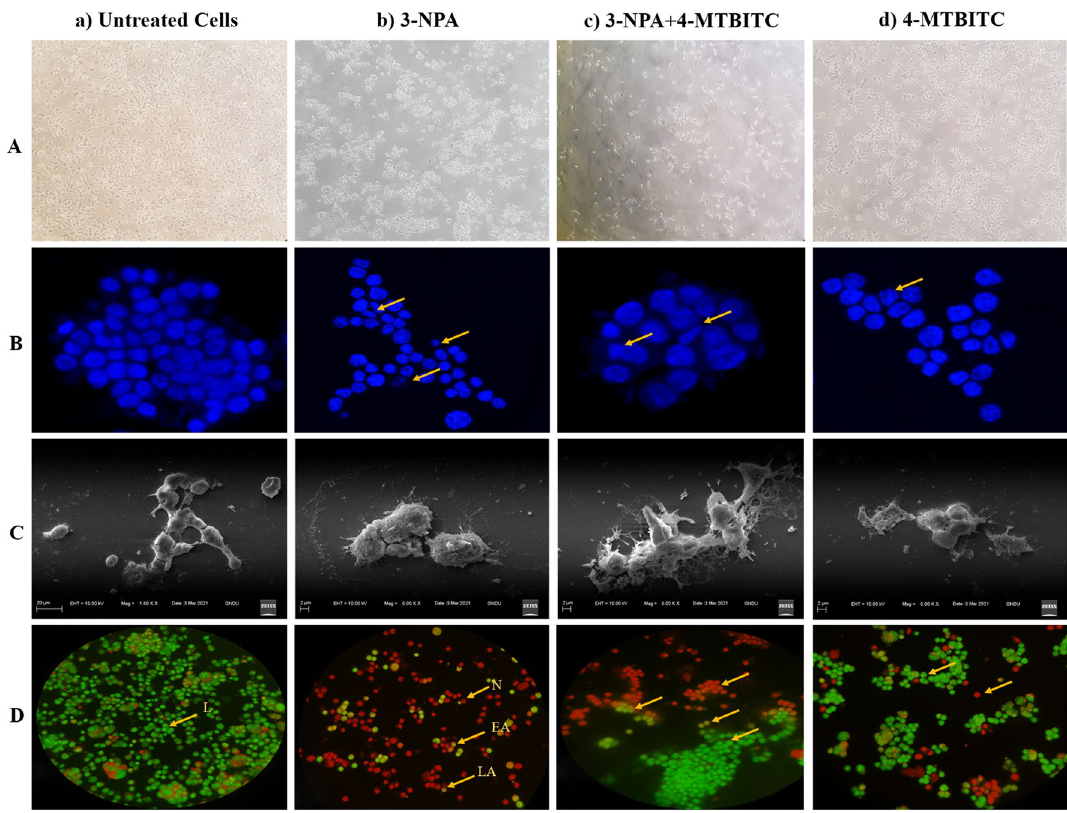
Figure 5. Representative microscopic images of neuroblastoma SH-SY5Y cells. ( A ) Brightfield images. ( B ) Fluorescent images of Hoechst staining showing 4-MTBITC mediated neuroprotection against SH-SY5Y cell death induced by 3-NPA exposure. ( C ) Scanning electron micrographs (SEM) of SH-SY5Y cells. ( D ) Fluorescence microscopic images of Acridine orange and ethidium bromide (AO/EtBr) double staining. Arrow indicated live (L) cells, early apoptosis (EA), late apoptosis (LA) and necrotic (N) cells in treated groups. (a) Untreated cells; (b) 3-NPA treated cells; (c) 3-NPA + 4-MTBITC treated cells; (d) 4-MTBITC alone treated